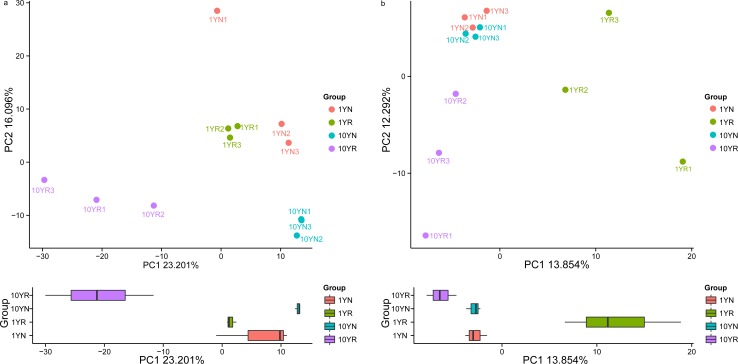
PCA of the OTUs detected major variations in the bacterial (a) and fungal (b) communities in healthy and continuous Ramie soil samples.